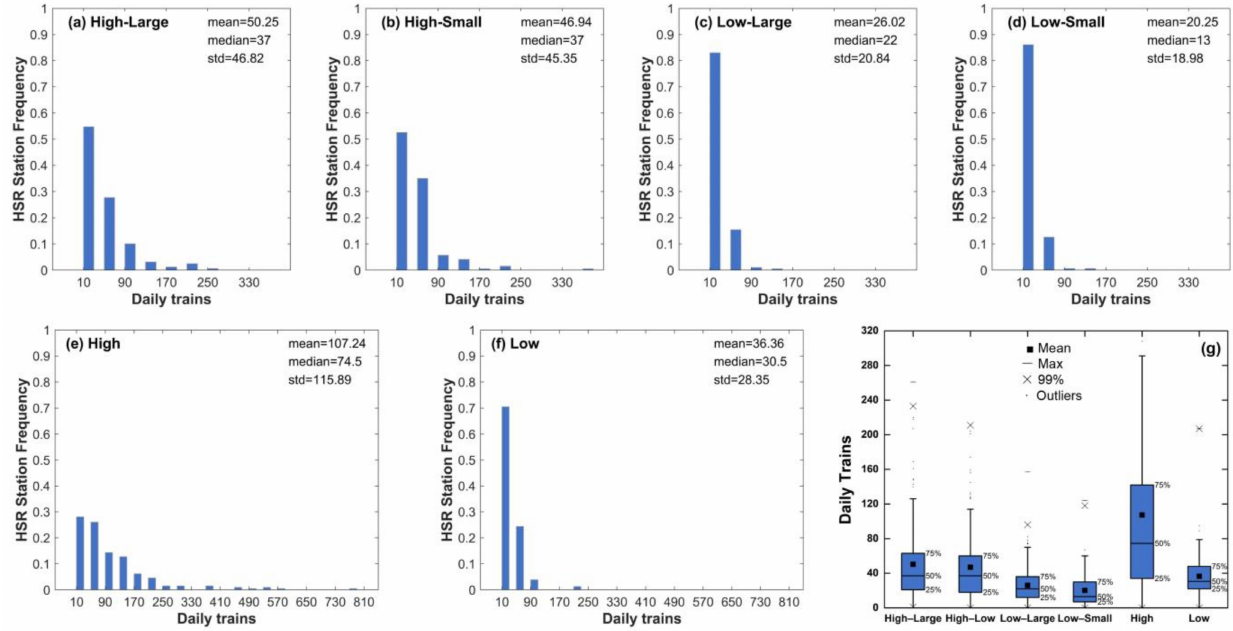
Figure 6. Impact of HSR daily trains on brightness. ( a – f ) Frequency distribution histogram of daily trains for different type of stations and ( g ) box chart of daily trains for different station